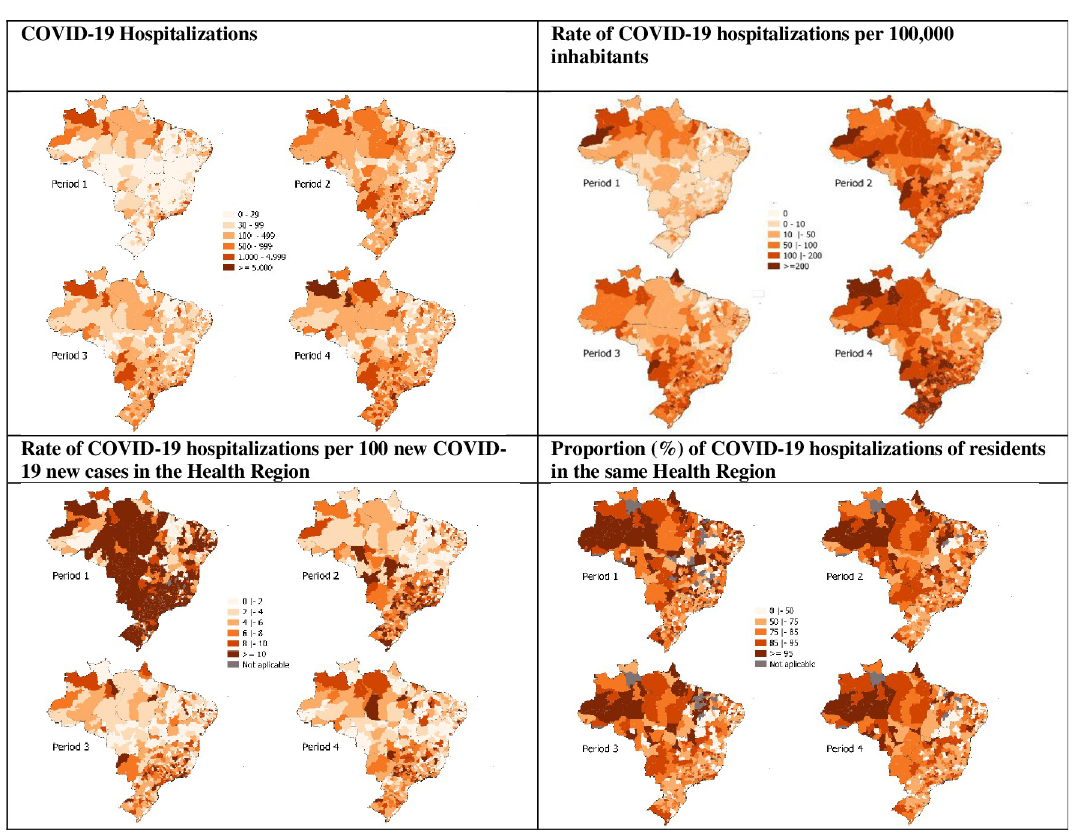
Fig 2. Spatiotemporal occurrence of COVID-19 hospitalizations. Brazil, epidemiological weeks 09/2020–11/2021, 23 Feb 2020–20 Mar 2021. Sources: SIVEP-Gripe, Minister of Health, Brazil; and Brasil.io. Periods: 1, epidemiological weeks 09-22/2020 (23 Feb